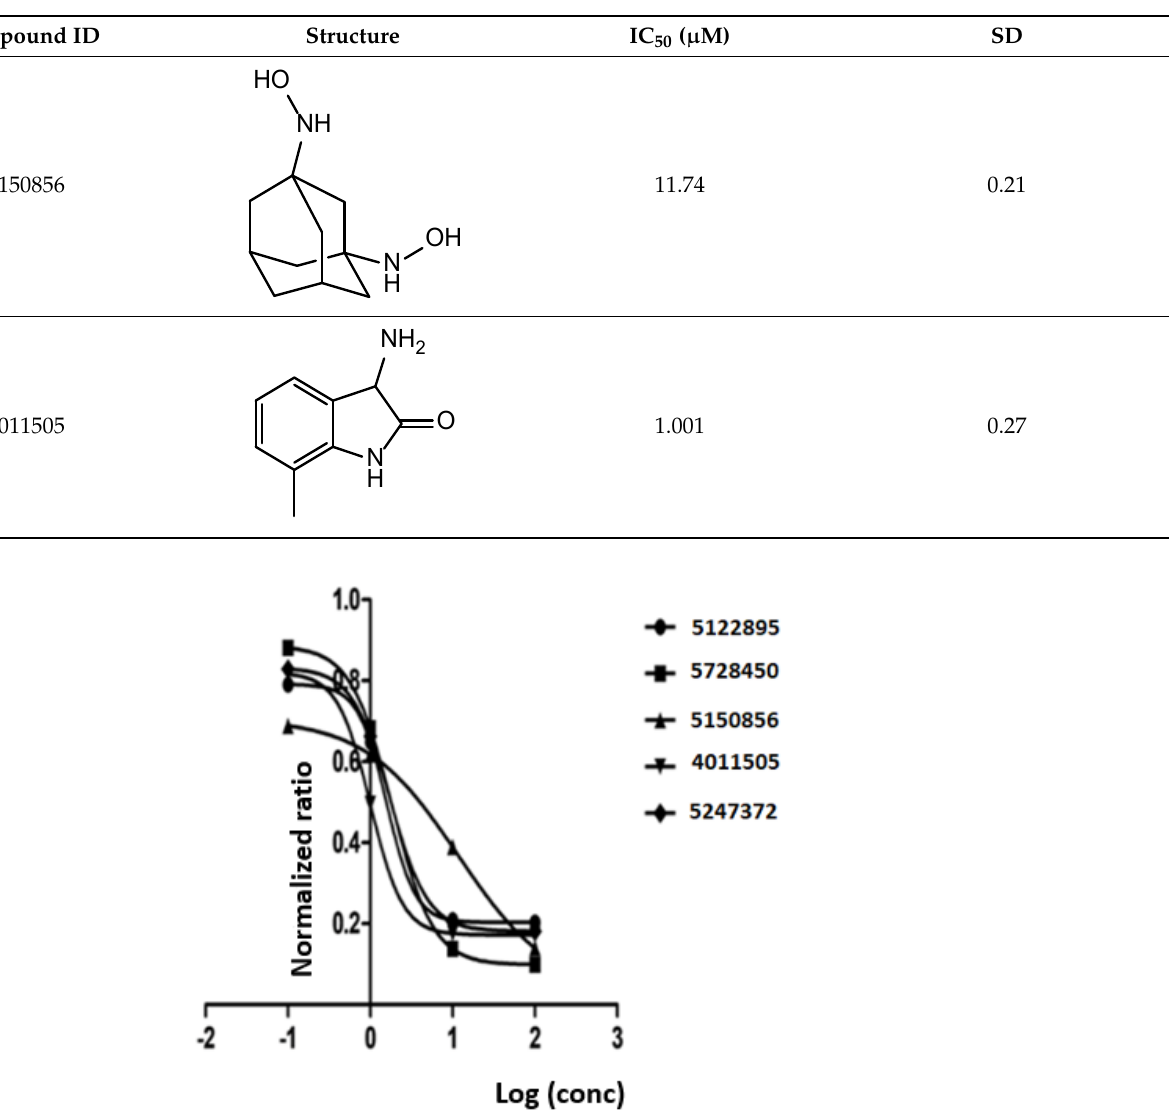
Figure 3. Dose-response in enzymatic assay for five inhibitors with the lowest IC 50 values. Dose- response is shown as the log of concentration (in microMolar) in relation to a normalized ratio.